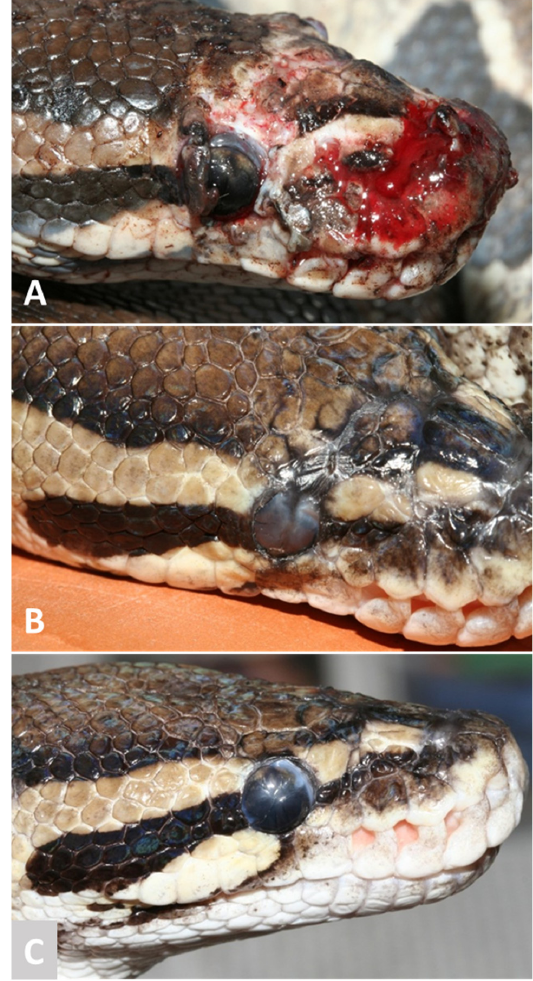
Figure 16. ( A ) Rat bite induced rostral trauma involving the spectacle in a ball python ( Python regius ). ( B ) Healing of the skin and spectacle following topical wound treatment and shedding (week 4). ( C ) Mild residual scarification of the skin and spectacle after a second shedding phase (week